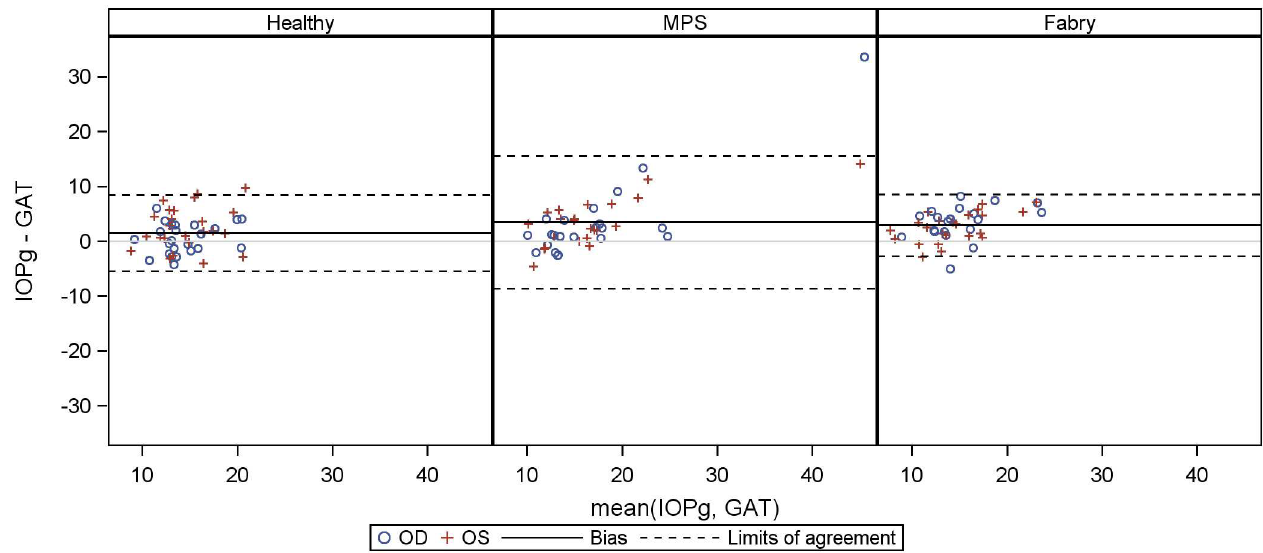
Fig 7. Bland-Altmann Plot for agreementbetween Goldmann applanation tonometry (GAT) and Goldmann-correlated IOP (IOPg).